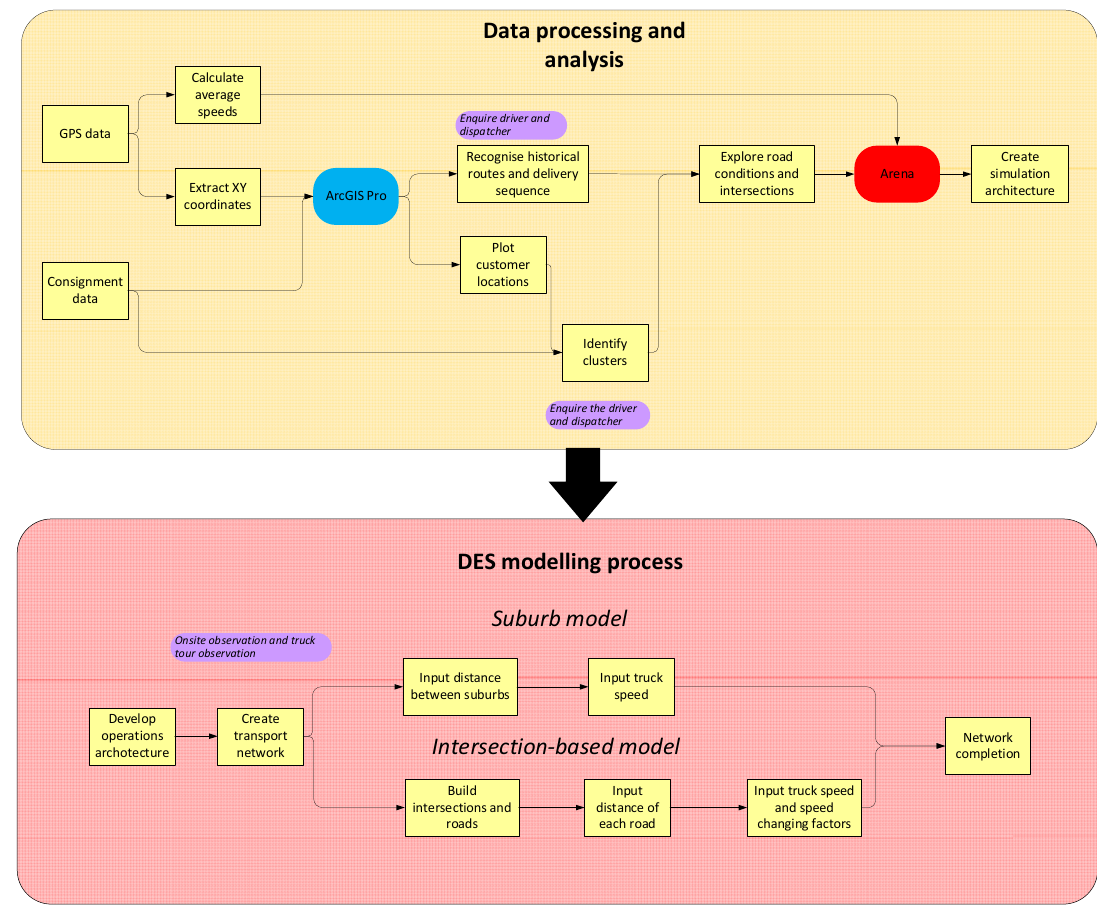
Figure 1. Workflow of combined GIS and DES simulation modelling approach.